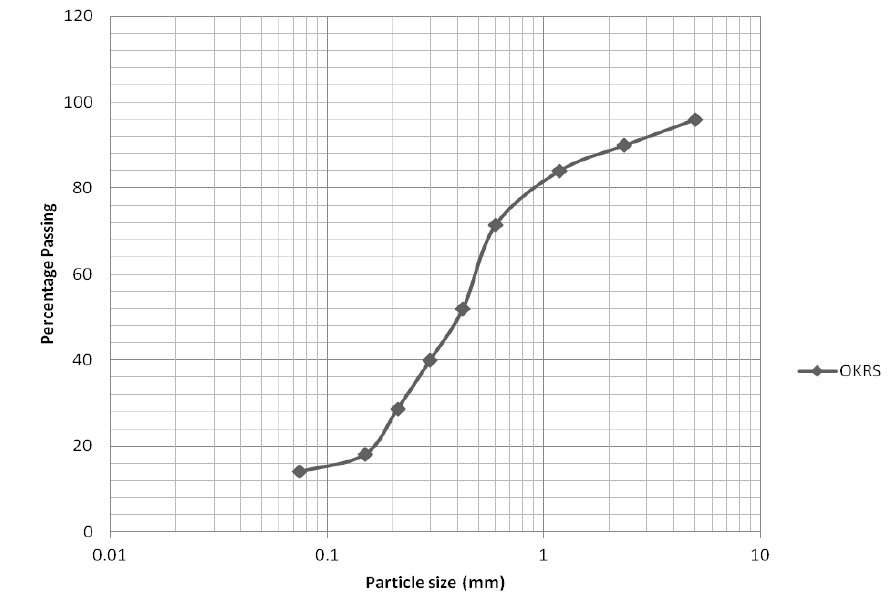
Figure 2. Grading curve for OKRS on a semi-logarithmic